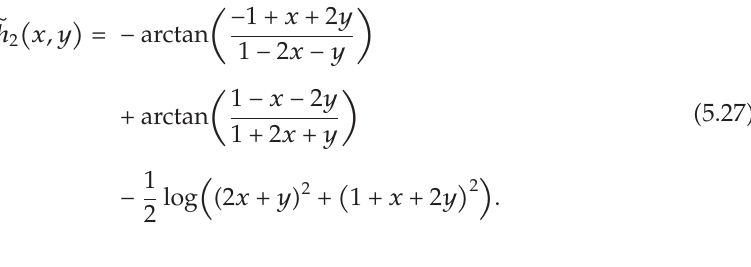
Figure 1: Visualization of the trajectories of (cid:3) 5.26 (cid:4) . In this case we have plotted level bands of the trajectories are in fact the boundaries between the colored bands. We have also plotted, in white, the trajectory that passes through a singular point corresponding to a pole of the (cid:3) complex (cid:4) analytic function (cid:2) g (cid:3) z (cid:4) . To exemplify the parametrization, we have plotted in black the points corresponding to t (cid:5) 0 , 1 , 2 , 3 (cid:3) see Table 1 (cid:4)